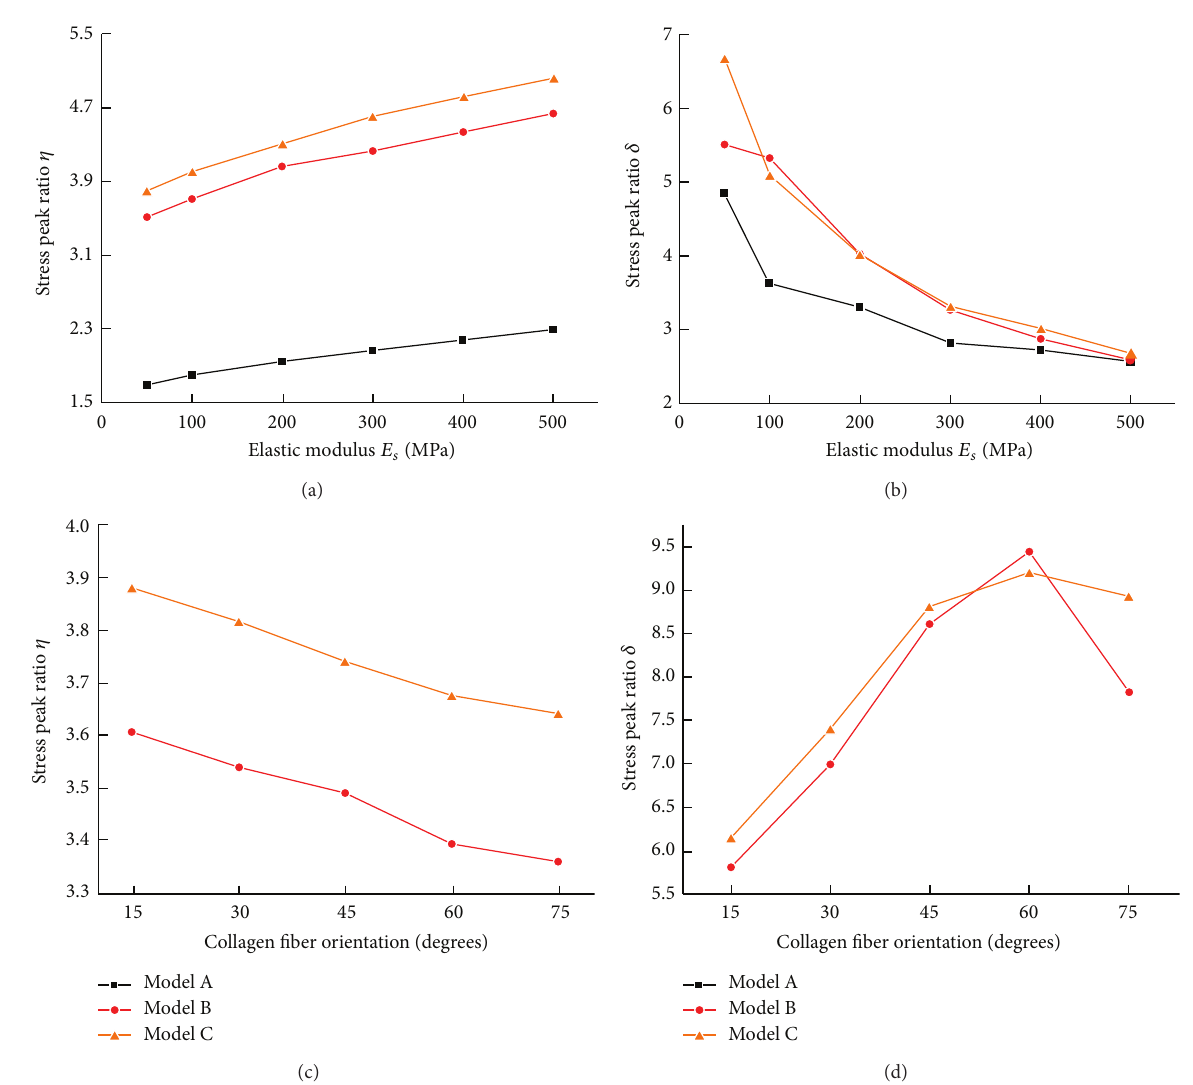
Figure 4: Variations of (a) stress peak ratios 𝜂 and (b) 𝛿 in the isotropic models as a function of the suture elastic modulus. Variations of (c) stress peak ratios 𝜂 and (d) 𝛿 in the orthotropic models as a function of the collagen fiber orientation.